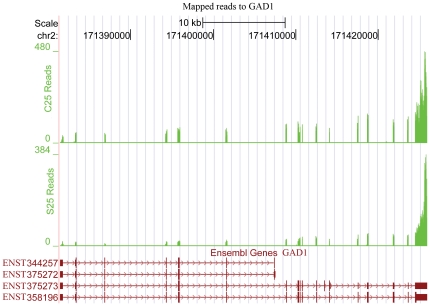
RNA sequencing reads of representative schizophrenia (S25) and control (C25) samples mapping to GAD1 gene.Y-axis indicates how many reads covering each base along the transcript. The schematic representations of the Ensembl transcripts for GAD1 are shown in brown at the bottom of the figure. This figure shows the difference in read counts covering GAD1 gene between the schizophreina representative sample S25 and the control representative sample C25.